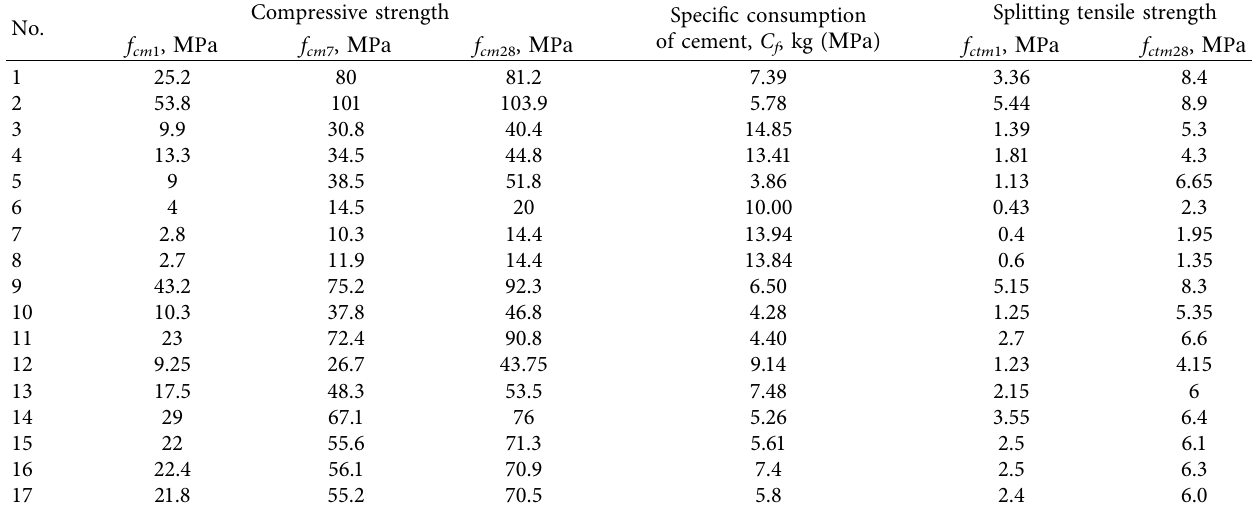
Table 5: Output parameters obtained in these